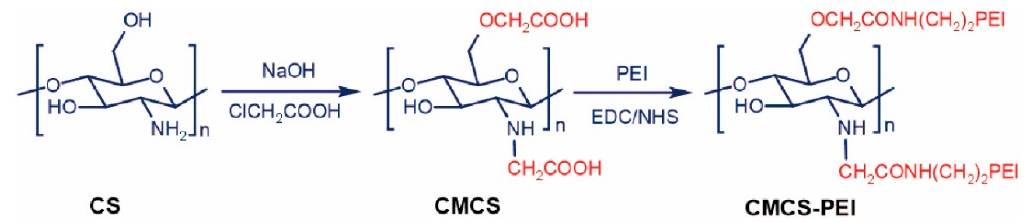
Figure 5. Scheme of the preparation of the CMCS–PEI copolymer [ 55 ].